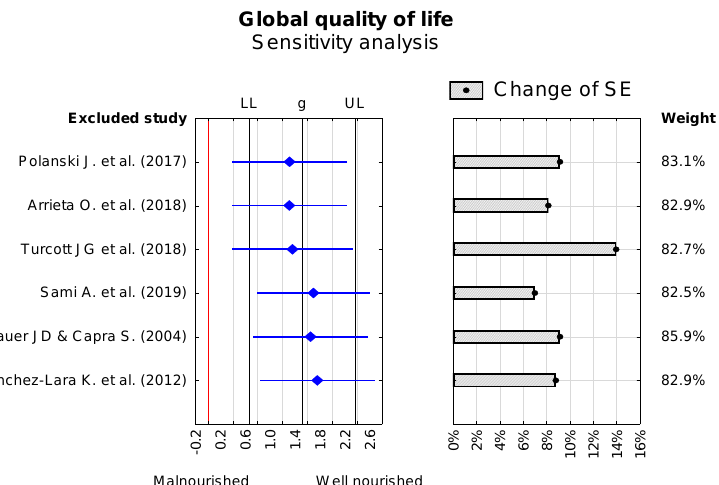
Figure 4. Sensitivity analysis for the impact of individual study exclusion on summary global QoL results (Hedge’s g).